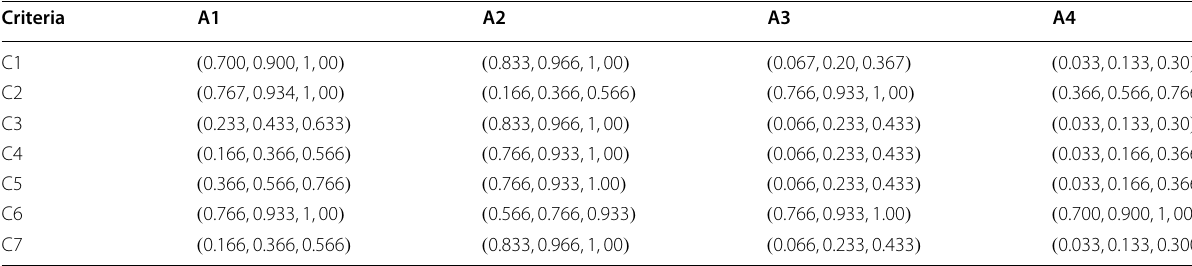
Table 10 Normalized fuzzy decision matrix Criteria